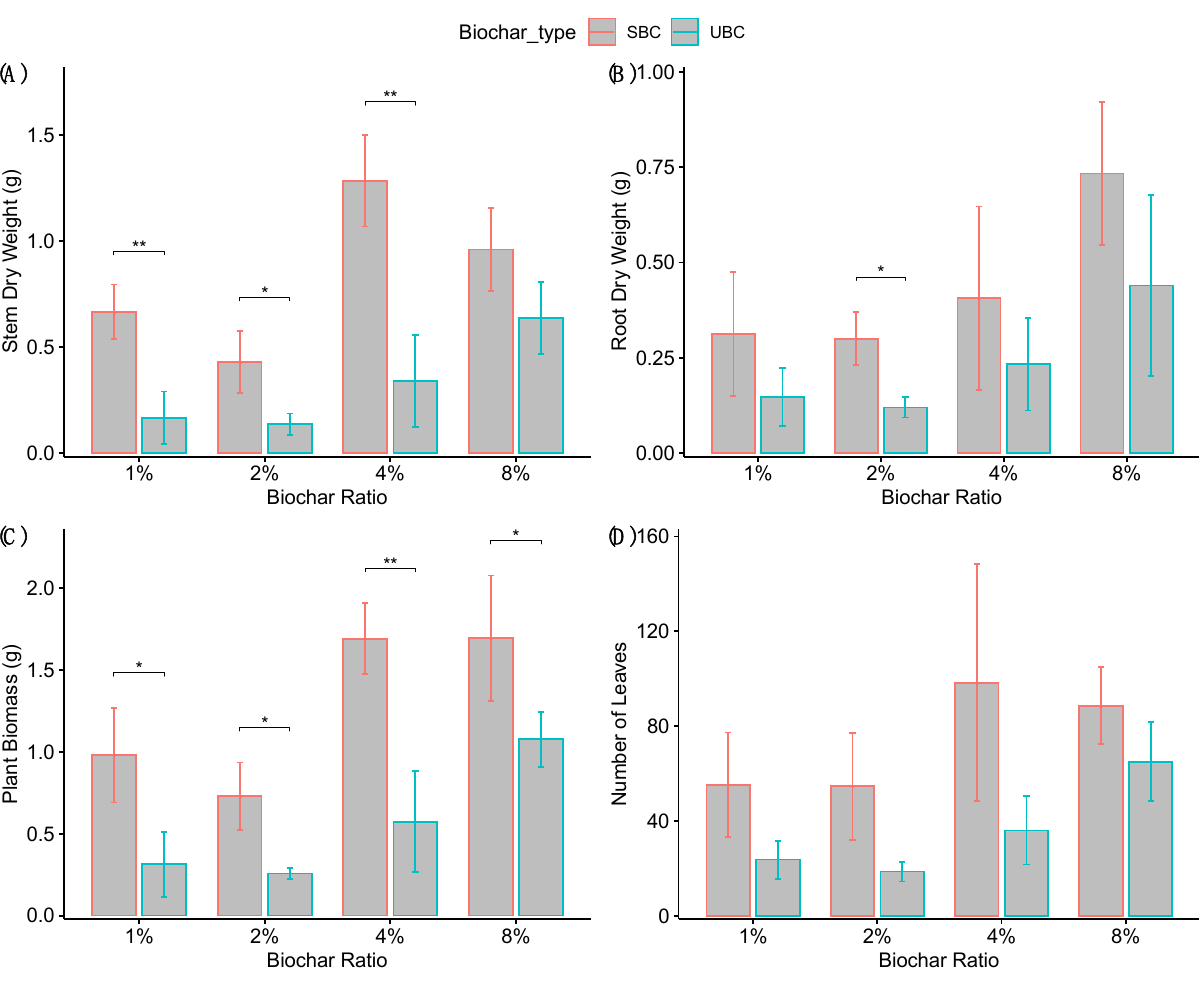
Figure 4. Comparison of stem dry weight ( A ), root dray weight ( B ), total plant biomass ( C ), and the number of leaves ( D ). Total plant biomass is the combination of stem and root dry weight. Two sample t -test was performed among each group compared ( p -value < 0.05 *, p -value < 0.01 **).